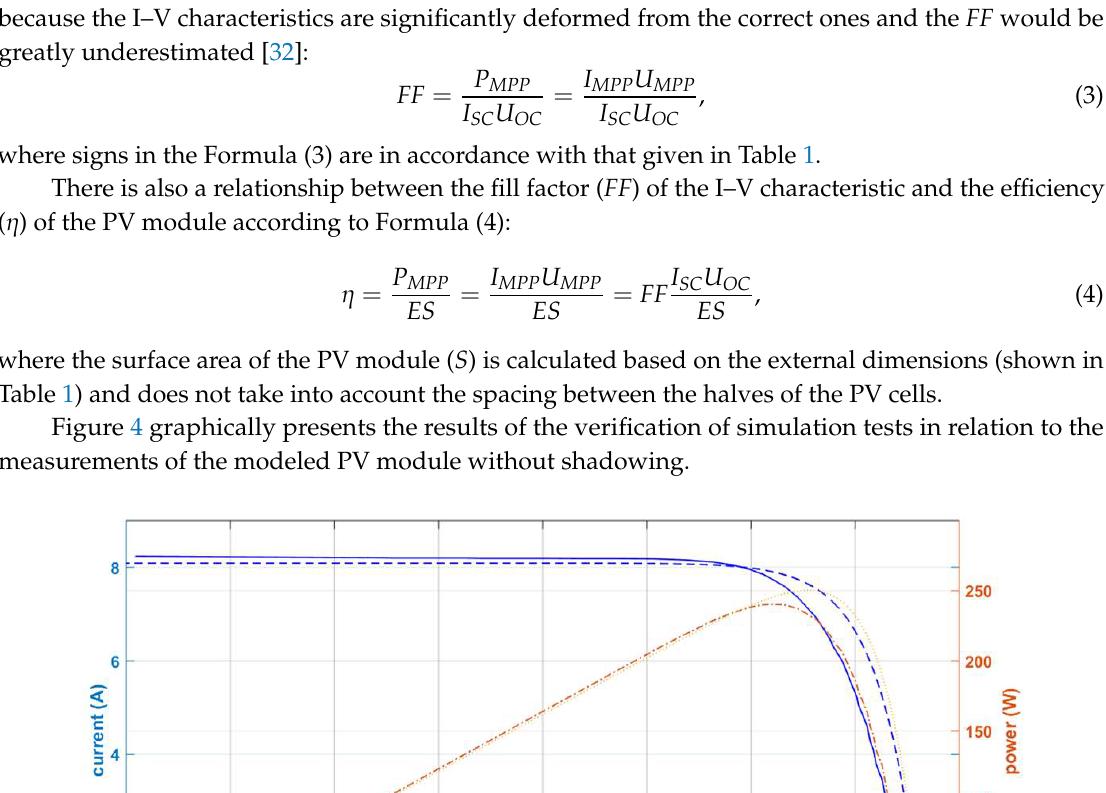
Table 3. Relative errors in the comparison of the basic parameters of the current–voltage (I–V) characteristics and the values of the fill factor ( FF ) and η coefficients for the measuring point P1 graphically shown in Figure 4 (for E = 810 W/m 2 , T M = 35.5 °C, and T amb = 23 °C).